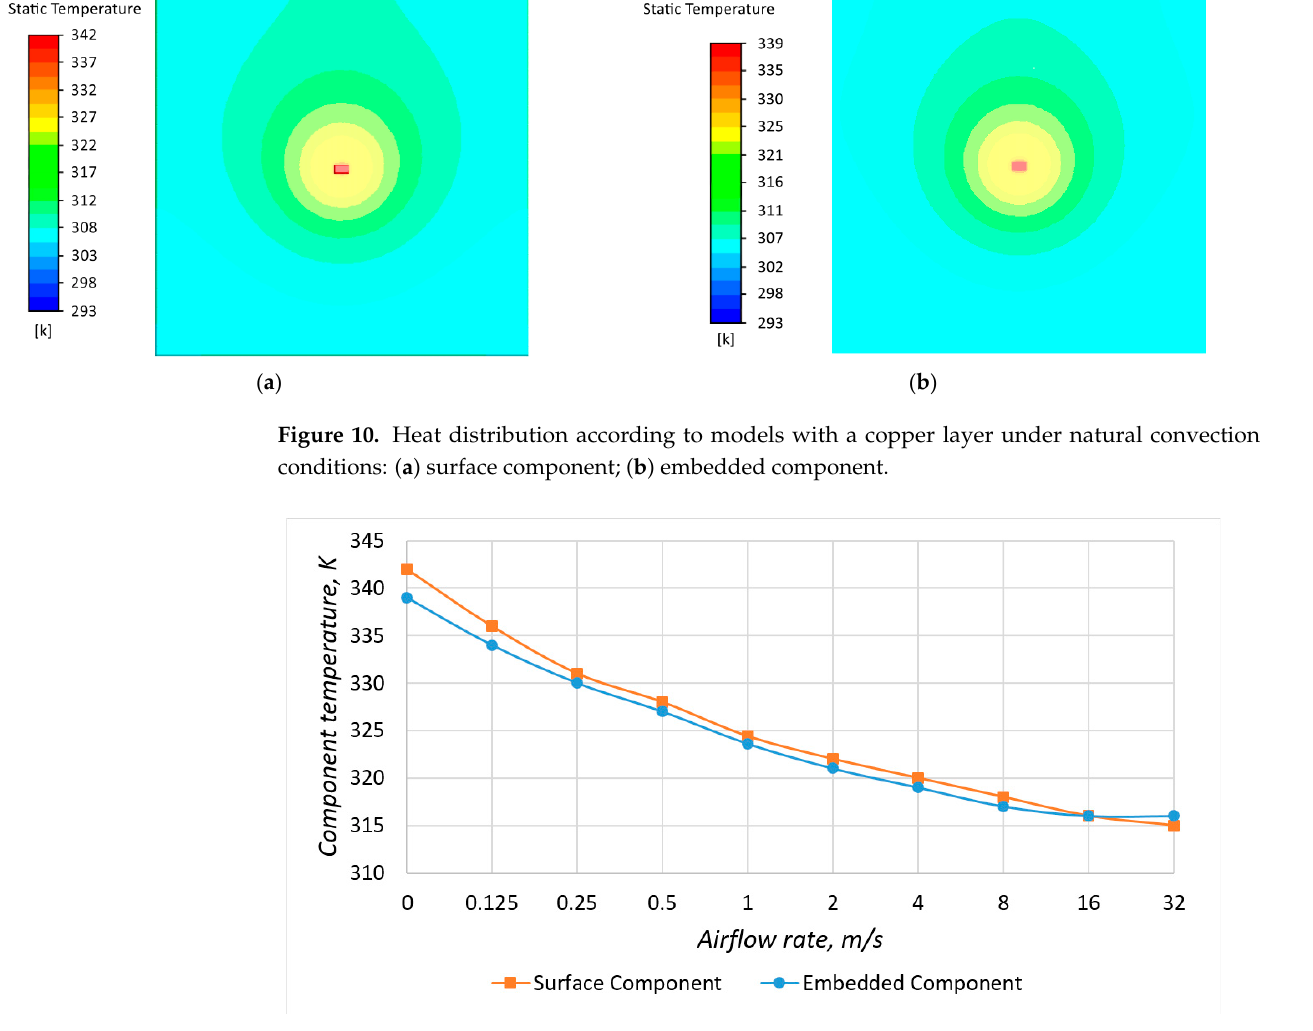
Figure 11. Dependence of the component temperature on the airflow rate in models with a copper